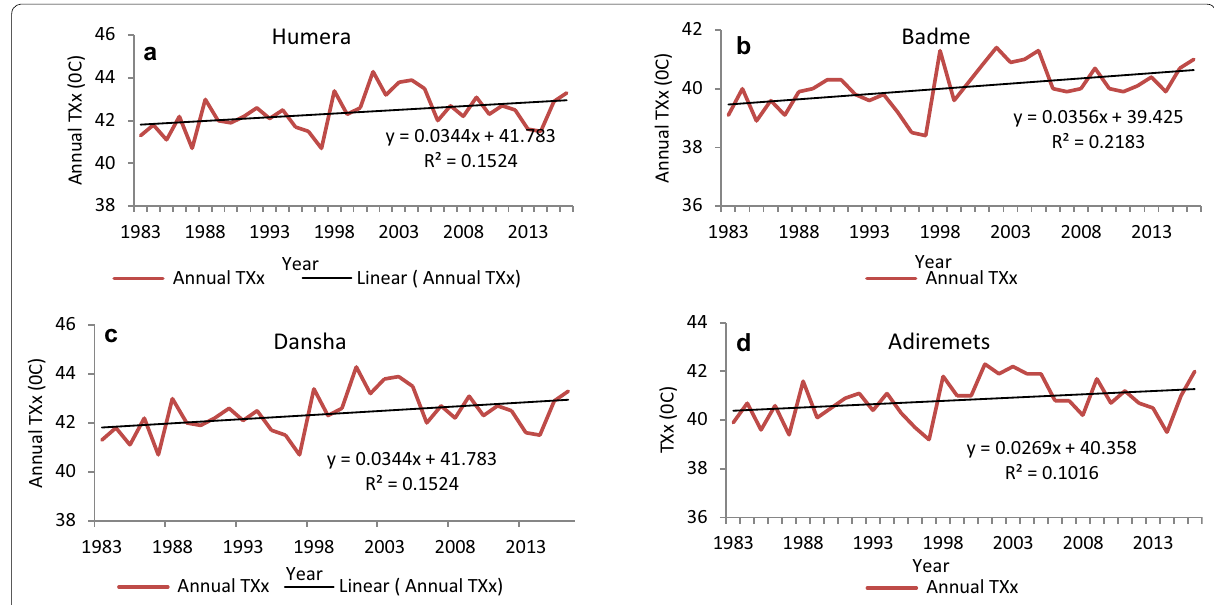
Fig. 2 Annual monthly maximum value of daily maximum temperature (TXx) at a Humera, b Badme, c Dansha, d Adiremets, e Sheraro and f